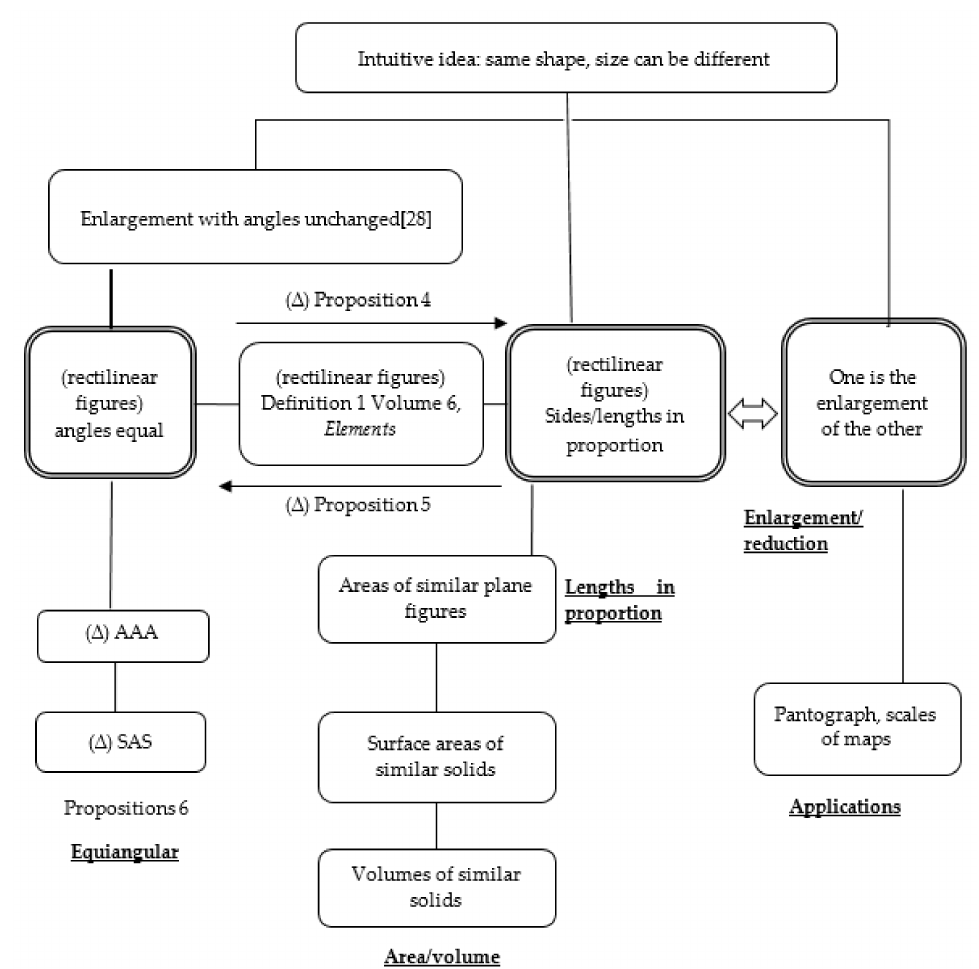
Figure 7. The overall structure of the topic of